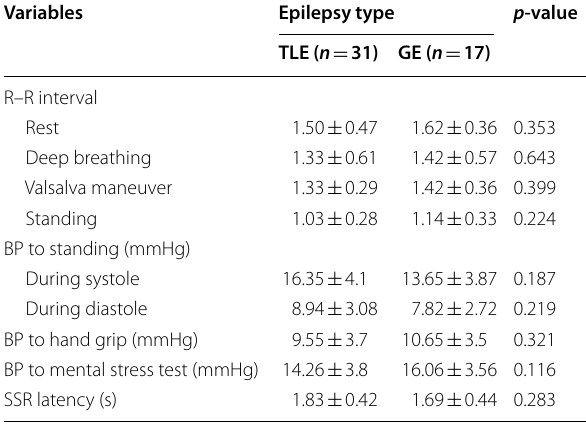
Table 3 Autonomic function tests in different types of epilepsy